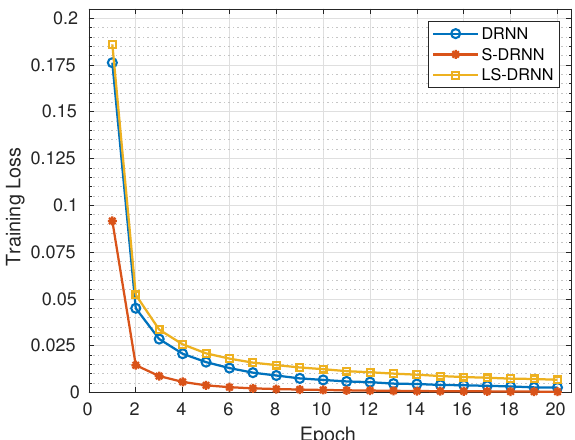
Figure 5. Cross-entropy losses during training.